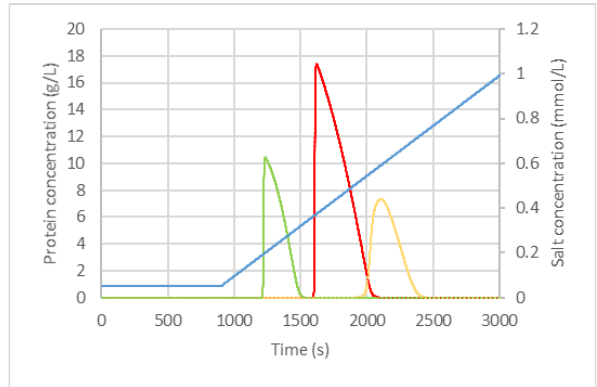
Figure 4. Chromatogram of the simulation with the original parameters (solid lines) and the resimulated chromatogram with the ANN-predicted parameters (dashed lines). The red lines represent the target component IgG, the green line the side component group HCP1, and the yellow line the side component group HCP2. The blue line represents the salt gradient. The predicted parameters have an error of lower than 5%, except for 𝑘 𝑒𝑓𝑓,𝐻𝐶𝑃2 . With values of ~0.02 cm 2 /s (original) and ~0.007 cm 2 /s , the error is 172%. Despite the high error of 𝑘 𝑒𝑓𝑓,𝐻𝐶𝑃2 , the original chromatogram and the resimulated chromatogram perfectly match with the coefficient of determination ( R²) of over 99%. The confidence interval at 95% level of the R 2 of the original and resimulated chromatograms of IgG is [97.4,99.9] , of HCP1 is [ 97.5,99.9] and of HCP2 is [97.1,99.4] . Hence, these parameters can be predicted from a single chromatogram with 𝑘 𝑒𝑓𝑓 only needing to be a rough estimate whether it is smaller or above 10 −4 cm 2 /s . 3.2. Variation of Phase Equilibrium Parameters To test the prediction ability of the phase equilibrium parameters, an FF-ANN with 118 input neurons, 117 neurons with 20% dropout and tanh activation in hidden layer 1, 100 neurons with tanh activation function and 20% dropout, and 12 output neurons with relu activation was implemented. As training algorithm, the Adam optimizer was utilized. The dataset of 1000 simulative experiments was split into 70% training and 30% validation data. Training was performed over 10,000 epochs with a batch size of 16. The R 2 values of the original values over predicted values of the test set are shown in Table 2. Table 2. Coefficient of determination of the phase equilibrium parameters from the test set. 𝒂 𝟏,𝑰𝒈𝑮 𝒂 𝟏,𝑯𝑪𝑷𝟏 𝒂 𝟏,𝑯𝑪𝑷𝟐 𝒂 𝟐,𝑰𝒈𝑮 𝒂 𝟐,𝑯𝑪𝑷𝟏 𝒂 𝟐,𝑯𝑪𝑷𝟐